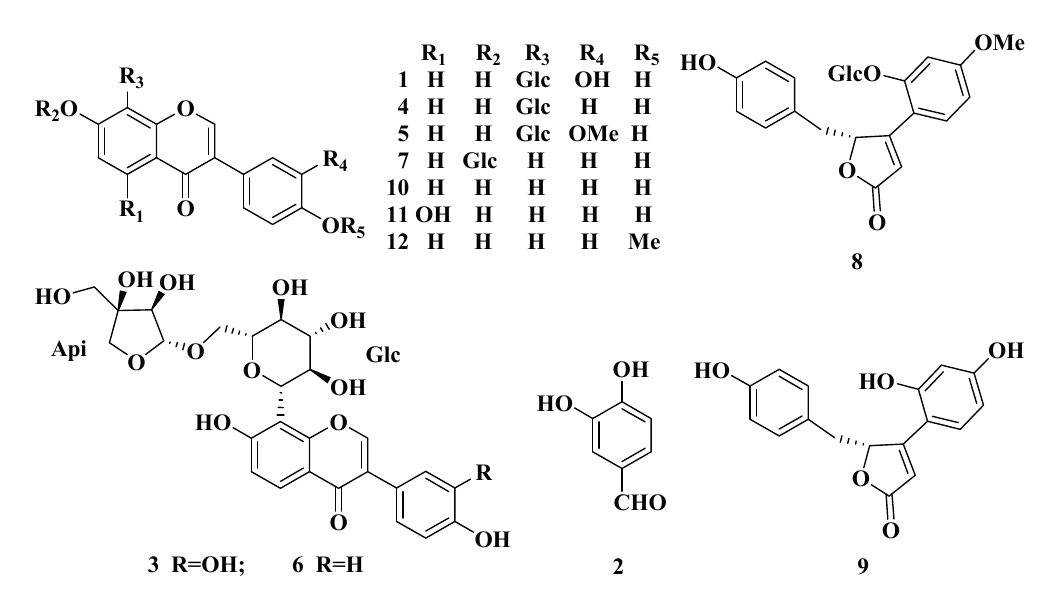
Figure 1. Chemical structures of the 12 main compounds from Tongmai Formula: 3 ′ -hydroxypuerarin ( 1 ), protocatechuic aldehyde ( 2 ), 3 ′ -hydroxymirificin ( 3 ), puerarin ( 4 ), 3 ′ -methoxypuerarin ( 5 ), mirificin ( 6 ), daidzin ( 7 ), (±)-puerol B-2 ″ - O -glucopyranoside ( 8 ), puerol A ( 9 ), daidzein ( 10 ), genistein ( 11 ), and formononetin ( 12